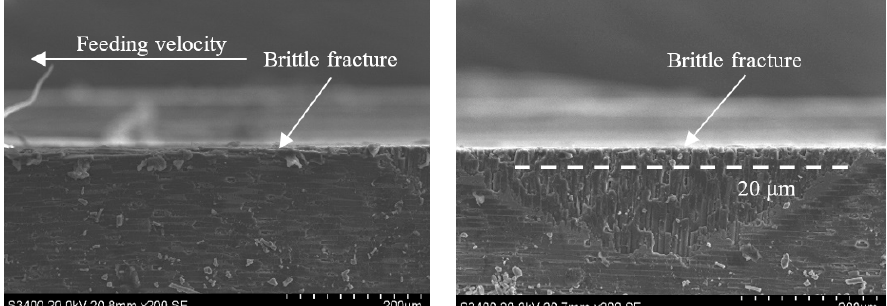
Figure 17. Grinding subsurface topography of the UAG-C/SiC composite (v s = 12.6 m/s, a p = 0.1 mm, v w = 100 m/min).